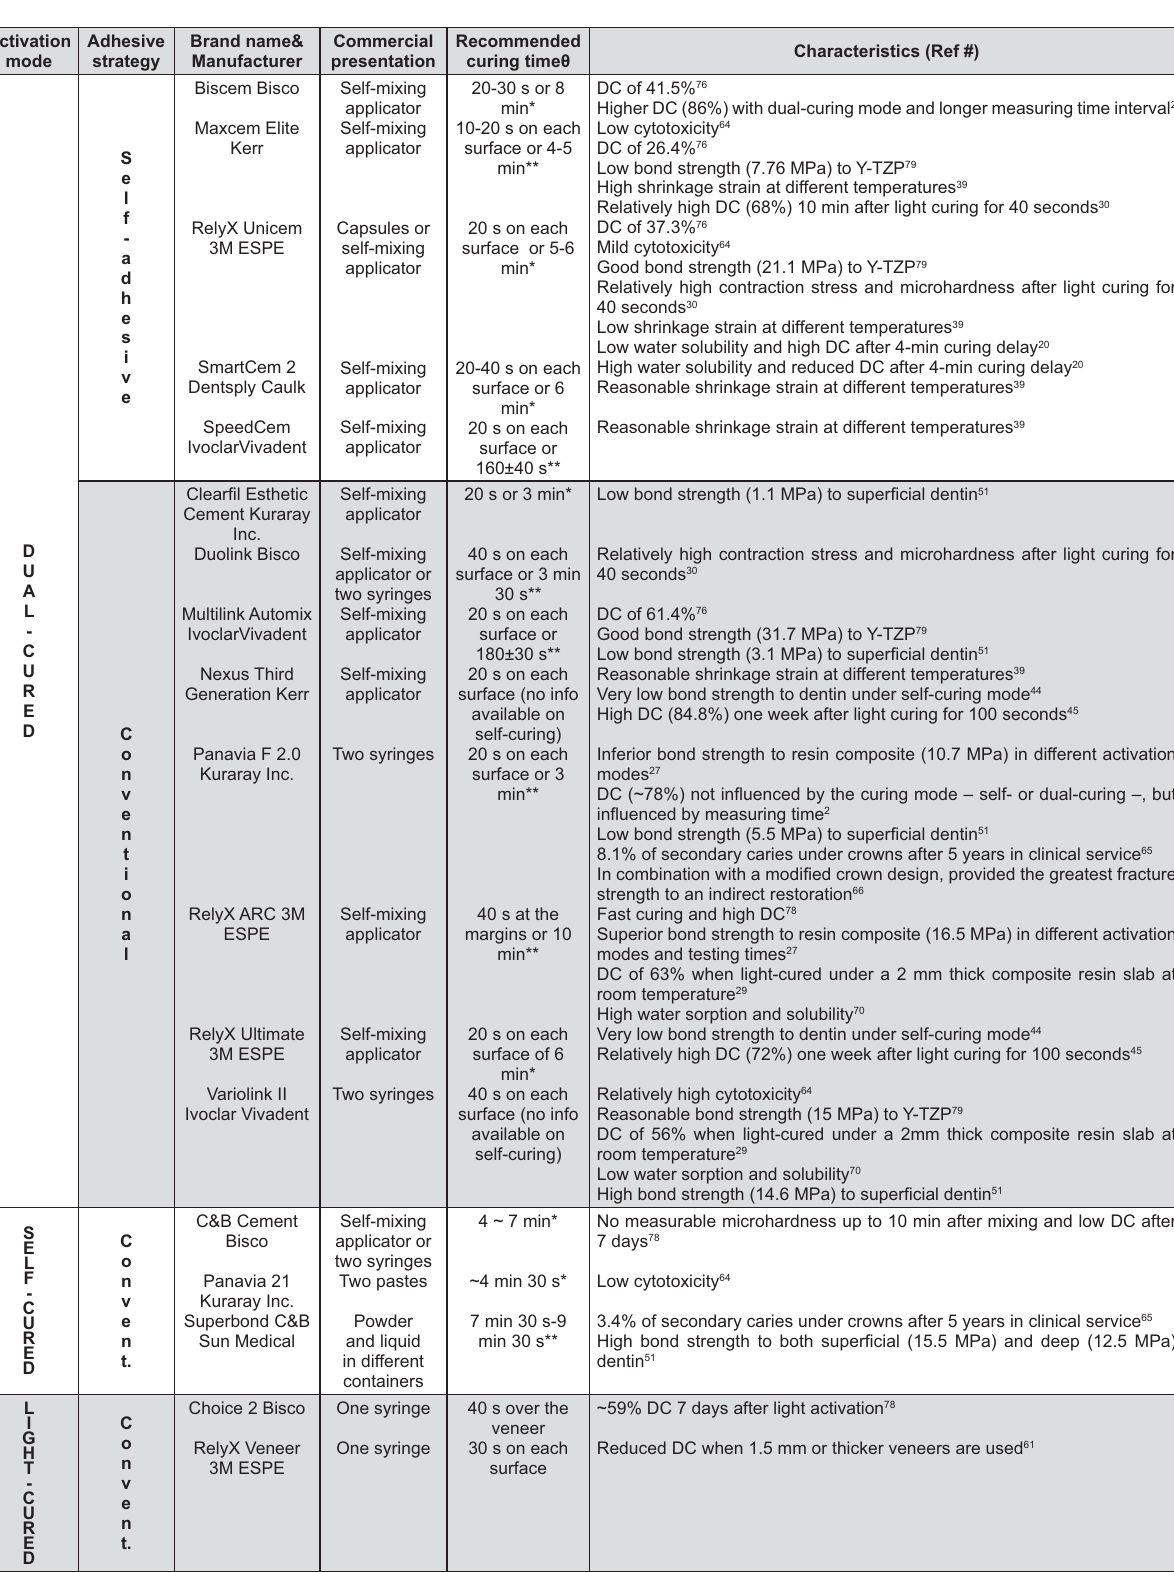
&Brand names mentioned were reproduced from the research papers included in this literature review. Therefore, there may be other brand names currently (cid:13)(cid:19)(cid:8)(cid:11)(cid:12)(cid:4)(cid:8)/(cid:5)(cid:6)_(cid:4)(cid:11)(cid:8)(cid:11)(cid:12)(cid:5)(cid:11)(cid:8)(cid:17)(cid:16)(cid:28)(cid:3)(cid:20)(cid:8)(cid:6)(cid:4)(cid:29)(cid:6)(cid:4)(cid:10)(cid:4)(cid:19)(cid:11)(cid:8)(cid:11)(cid:12)(cid:4)(cid:8)(cid:14)(cid:5)(cid:11)(cid:4)(cid:21)(cid:16)(cid:6)(cid:13)(cid:4)(cid:10)(cid:8)(cid:16)<(cid:8)/(cid:5)(cid:11)(cid:4)(cid:6)(cid:13)(cid:5)(cid:3)(cid:10)(cid:8)(cid:20)(cid:4)(cid:10)(cid:14)(cid:6)(cid:13)(cid:18)(cid:4)(cid:20)(cid:8)(cid:13)(cid:19)(cid:8)(cid:11)(cid:12)(cid:13)(cid:10)(cid:8)‘(cid:5)(cid:18)(cid:3)(cid:4)(cid:24)(cid:8)j(cid:15)(cid:13)(cid:21)(cid:12)(cid:11)=(cid:14)(cid:28)(cid:6)(cid:13)(cid:19)(cid:21)(cid:8)(cid:11)(cid:13)/(cid:4)(cid:8)(cid:6)(cid:4)(cid:14)(cid:16)//(cid:4)(cid:19)(cid:20)(cid:4)(cid:20)(cid:8)<(cid:16)(cid:6)(cid:8){‘W(cid:8)(cid:16)(cid:6)(cid:8)(cid:15)(cid:9)(cid:31)(cid:8)(cid:14)(cid:28)(cid:6)(cid:13)(cid:19)(cid:21)(cid:8)(cid:20)(cid:4)Q(cid:13)(cid:14)(cid:4)(cid:10)(cid:24)(cid:8)(cid:31)(cid:28)(cid:5)(cid:3)(cid:8) and self-curing times may either consider room temperature (~23°C) or mouth temperature (~37°C). *Time after starting the mixture. **Time after placement of prostheses DC=degree of conversion; LED=light-emitting diodes;